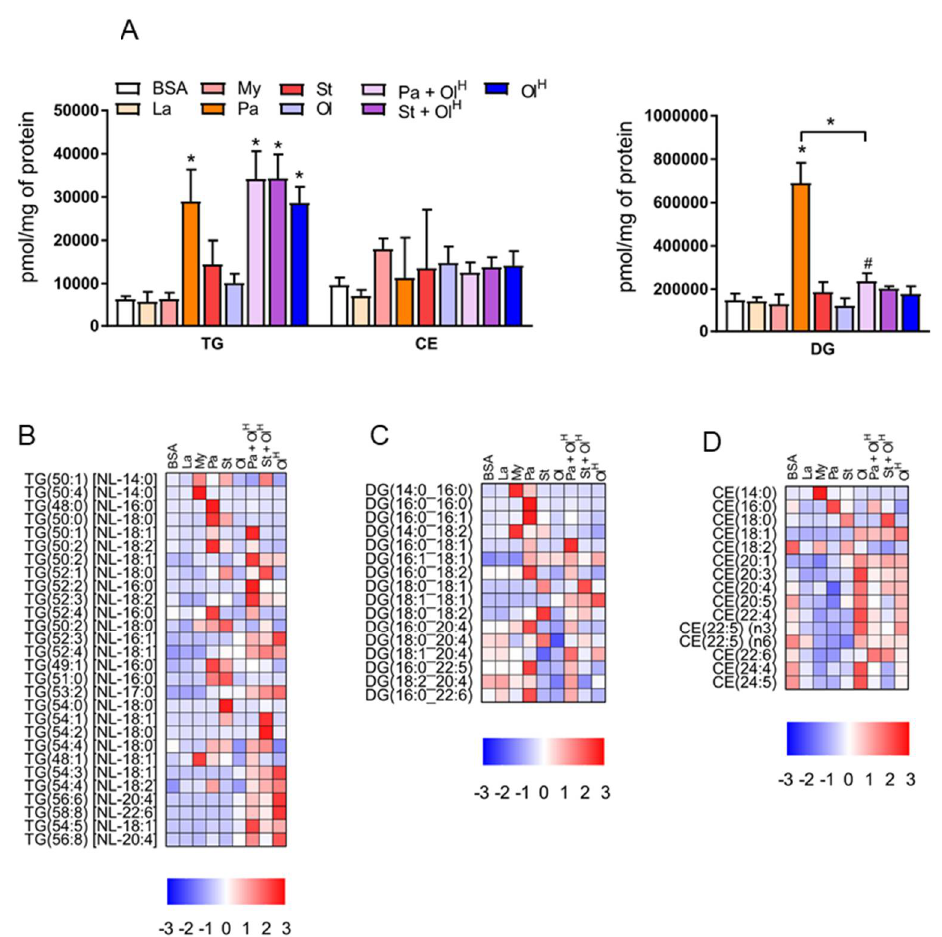
Figure 2. The effects of fatty acids on TG, DG and cholesteryl ester levels. ( A ) Concentrations of total TG (triacylglycerol), DG (diacylglycerol) and CE (cholesteryl esters) in BMDM treated with the indicated fatty acids. Data in A are the mean + SD. Symbols represent statistical significance compared with BSA or, where specifically indicated, between two particular groups at the following α levels: * p ≤ 0.001; † p ≤ 0.01; # p ≤ 0.05. ( B – D ) Heat maps showing the indicated lipid species within TG (B), DG (C) and CE (D), following treatment with fatty acids. Data are presented as Z-score by row. TG, DG and CE are ordered by sum composition of the acyl chains. Data are from 6 independent mice.